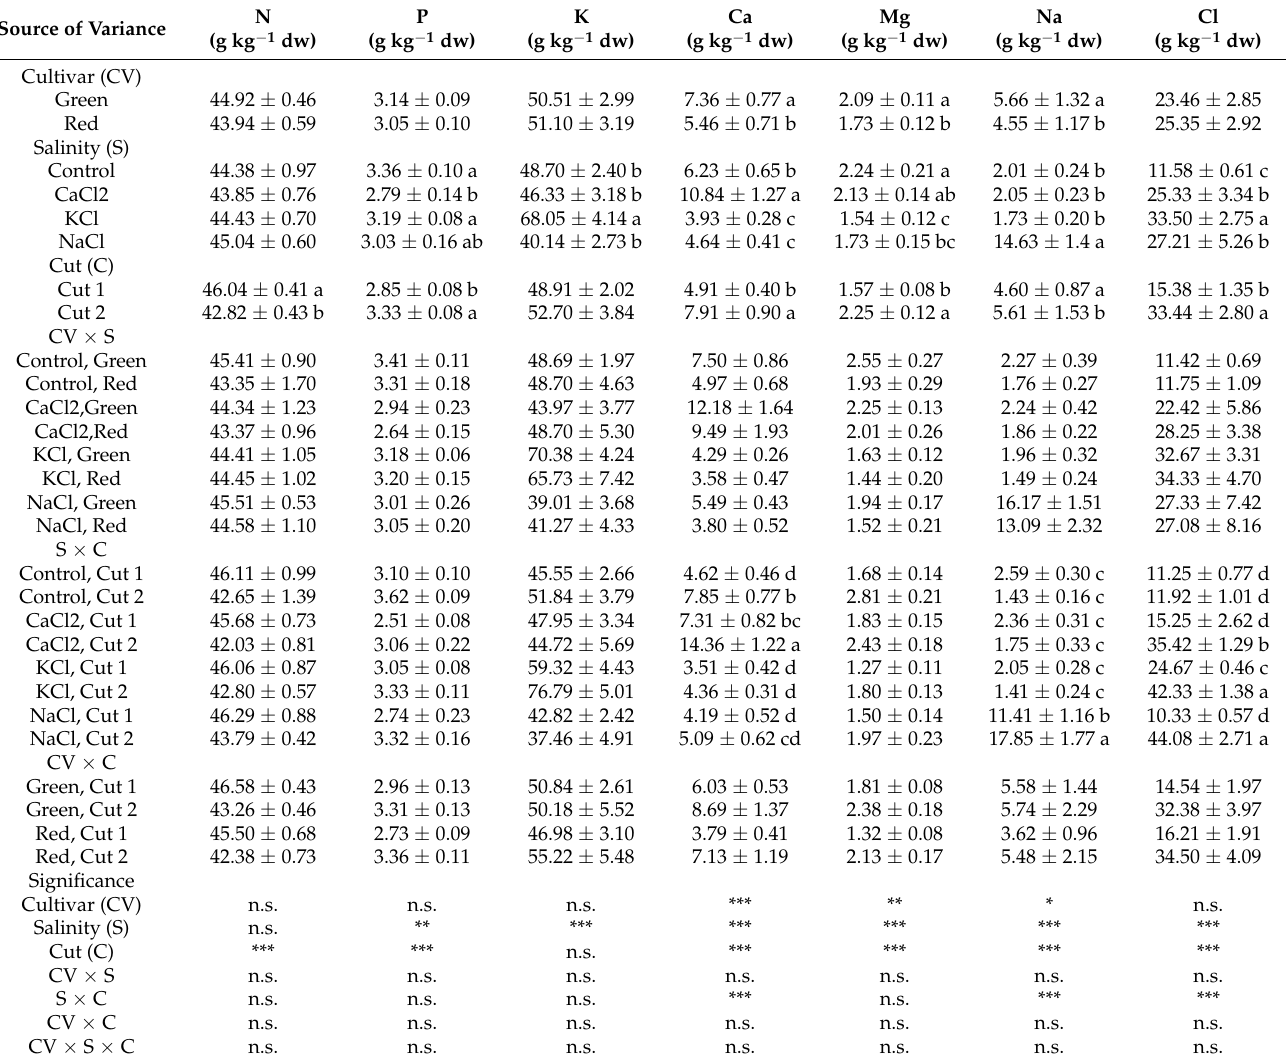
Table 3. Significance of the main factors (cultivar, salinity, and cut order) and their interactions on leaf mineral compo- sition (total nitrogen [N], phosphorus [P], potassium [K], calcium [Ca], magnesium [Mg], sodium [Na], chloride [Cl]) of Lactuca sativa L. var. acephala grown in a floating system. Source of Variance Cultivar (CV)